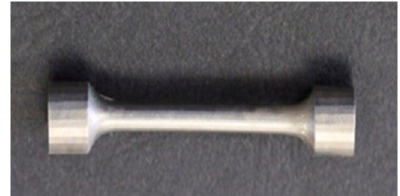
Figure 1. Example of shape of tested dumbbells.